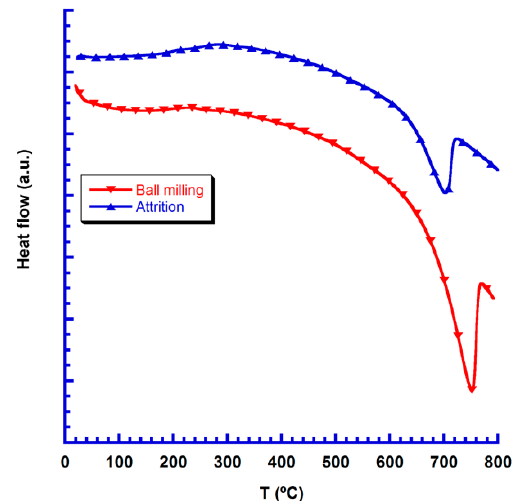
Figure 2. DTA graph of the dry precursors after milling.